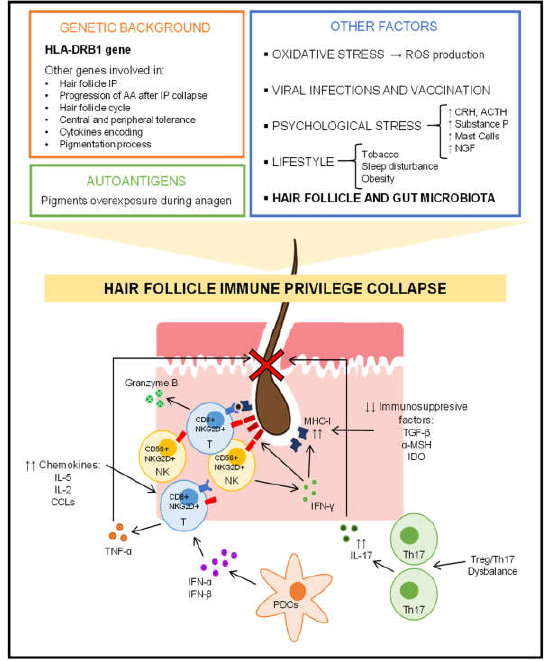
Figure 1. Overview of the pathogenesis of alopecia areata. IP: Immune privilege; AA: Alopecia Ar- eata; ROS: Reactive Oxygen Species; CRH: Corticotropin-Releasing Hormone; ACTH: Adrenocorti- cotropic Hormone; NGF: Nerve Growth Factor; IL-2: Interleukin 2: IL-5: Interleukin 5; IL-17: Inter- leukin 17; CXCLs: CXC Ligands; TNF-α: Tumor Necrosis Factor α; INF-α: Interferon α; INF-β: In- terferon β. INF-γ: Interferon γ; PDCs: Plasmacytoid dendritic cells; NK: Natural Killers; Th17: T- cells Th17; Treg: T-cells Treg; MHC-I: Major Histocompatibility Complex Class I; NKGD2D: NK Cell